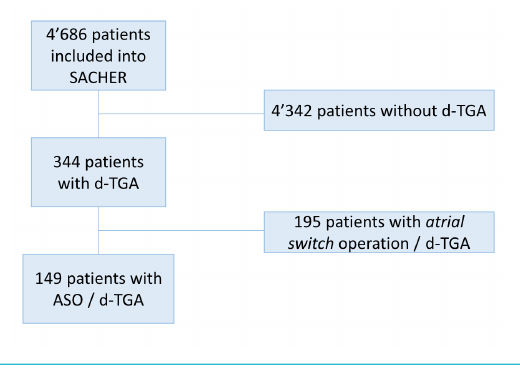
Figure S1: Flow chart. Out of a total of 4,686 patients included in SACHER, 344 (7%) had d-TGA, of whom 195 (57%) were operat- ed on with an atrial switch and have been excluded from the analy- sis. All patients with d-TGA who were operated with an ASO have been included in the analysis (no exclusion criteria).